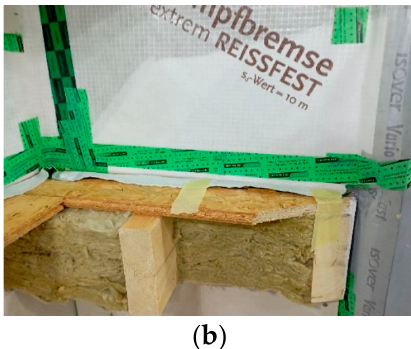
Figure 15. Variant 2 with additional tape to connect the top and bottom foil: ( a ) re-taping in the corner; ( b ) thorough sealing of the fragment.